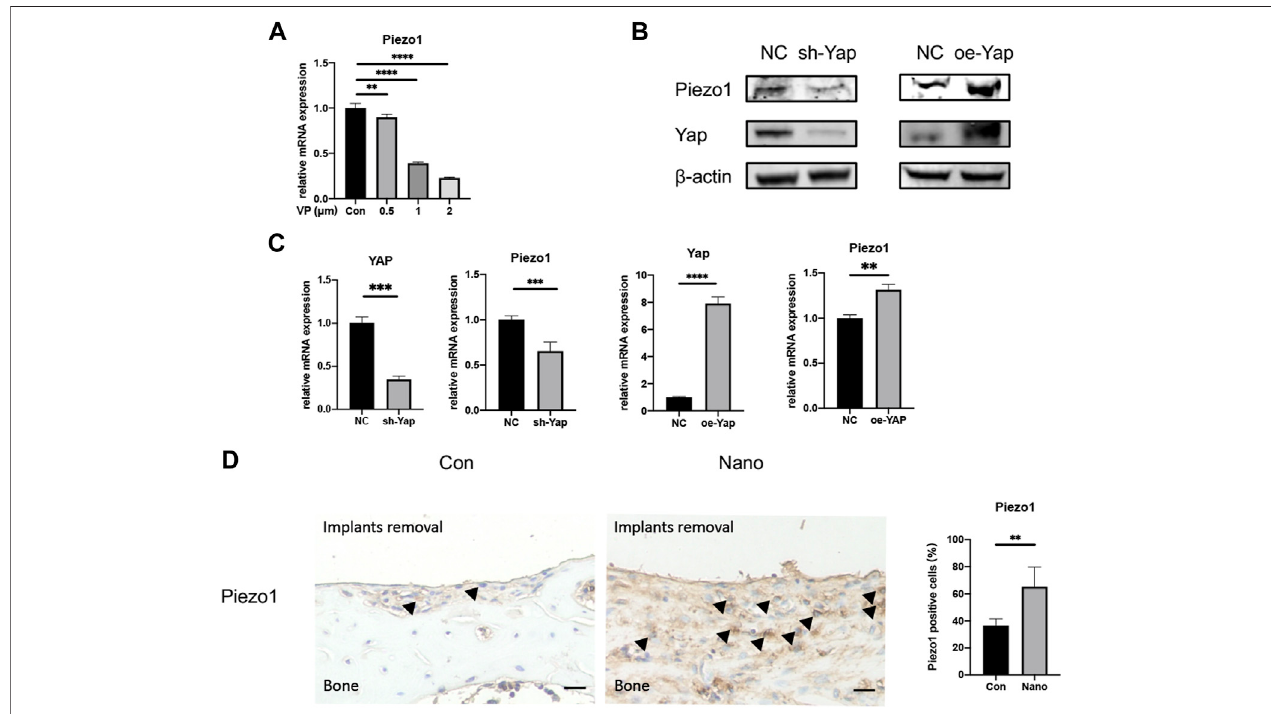
FIGURE 6 | Yap could regulate the expression of Piezo1. (A) Vertepor fi n inhibits expression of Piezo1 in a dose-dependent manner. (B) Knockdown or overexpression of Yap could regulate the protein expression of Piezo1. oe, overexpression. (C) Knockdown or overexpression of Yap could regulate the mRNA expression of Piezo1. (D) Expression of Piezo1 was elevated in bones around defects by immunohistochemistry and quantitative analysis. Scale bar: 10 μ m * p < 0.05, ** p < 0.01, *** p < 0.001, and **** p < 0.0001.